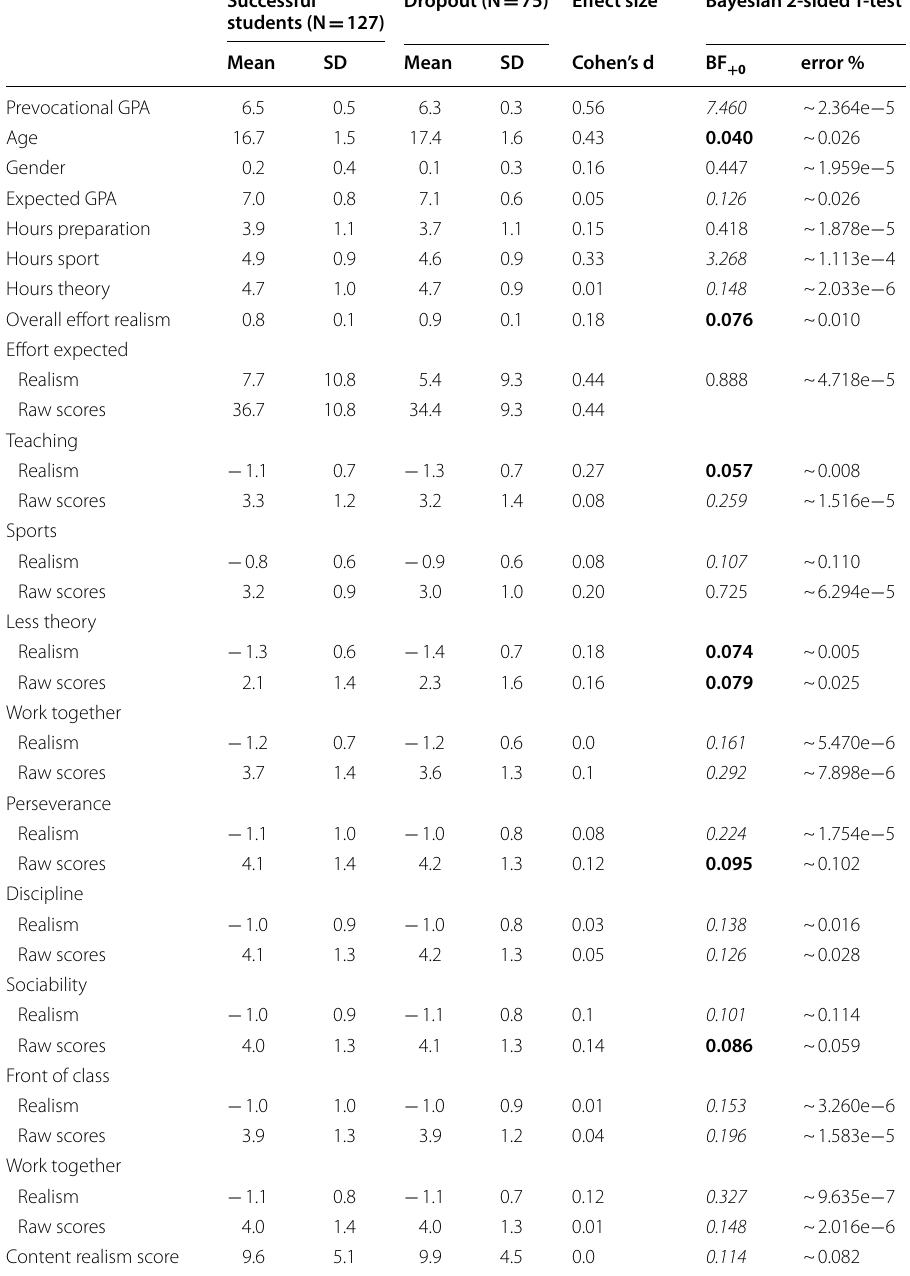
Table 5 Descriptives and expectations questionnaire responses for students who were after one year successful or had dropped